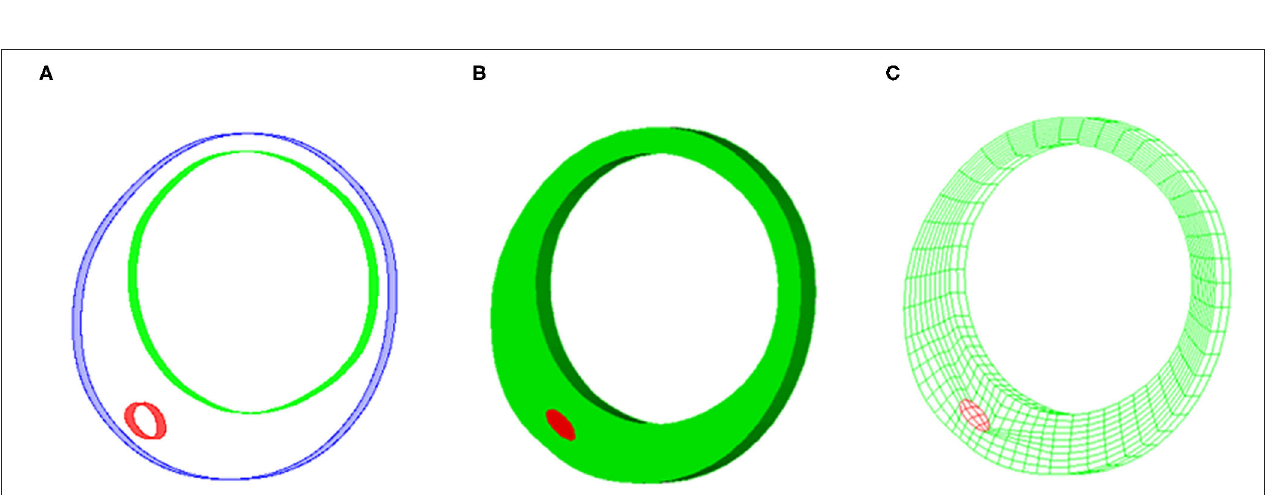
FIGURE 2 | Sample plaque showing reconstructed plaque geometry and finite element mesh for three-dimensional (3D) thin-slice structure-only model. (A) Reconstructed 3D thin-slice plaque geometry. (B) Reconstructed plaque volume. (C) Finite element